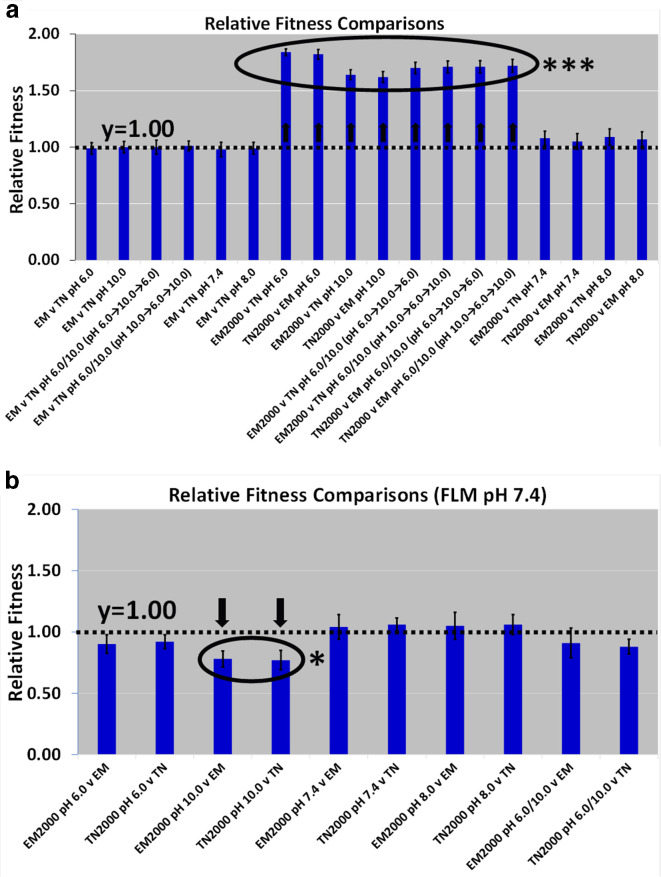
Relative fitness values were calculated with one-sample t-tests (two-tailed, Type 1 α error=0.05) and compared to H
0=1.00 (n=20). Relative fitness of the evolved lines were competed against the ancestors after 2000 generations. 6a. Competitions occurred between ancestors and derived lines in FLM pH where evolution took place. 6b. Competitions occurred between ancestors and derived lines in FLM pH 7.4. Key: v=versus, (pH 6.0→10.0→6.0)/(pH 10.0→6.0→10.0)=competition scheme involving pH generalists, EM=ancestral/unevolved 
V. fischeri
 EM17, TN=ancestral/unevolved 
V. fischeri
 EM17Tn7, EM2000=
V. fischeri
 EM17 evolved for 2000 generations, and TN2000=
V. fischeri
 EM17Tn7 evolved for 2000 generations. Error bars represent standard error of the mean. The broken horizontal line signifies y=1. Circled means are significantly different (*=0.01 <P≤0.05 and ***=P≤0.001), and arrows indicate the direction that relative fitness changed.